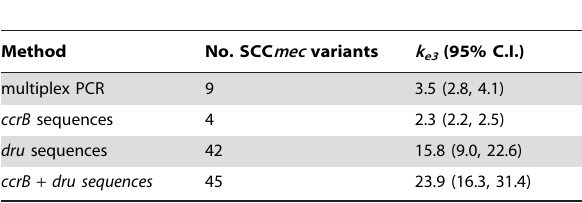
Table 4. SCC mec type III variation as detected by different typing methods.